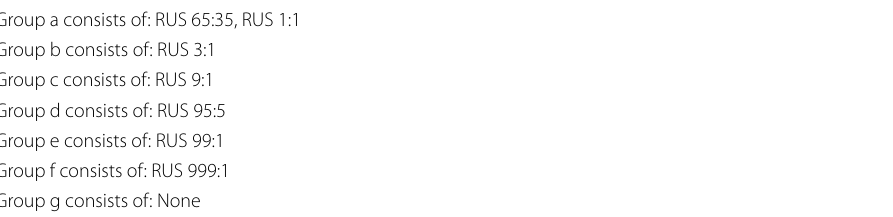
Table 17 HSD groupings of sampling ratios after 2-factor ANOVA where classifier and sampling ratio are factors with XSS web attacks; groups are by performance in terms of